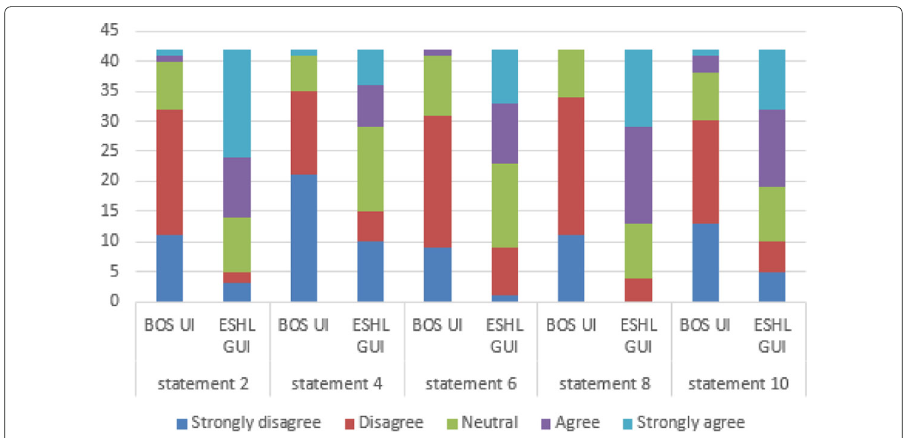
questionnaire about the BOS UI and the ESHL